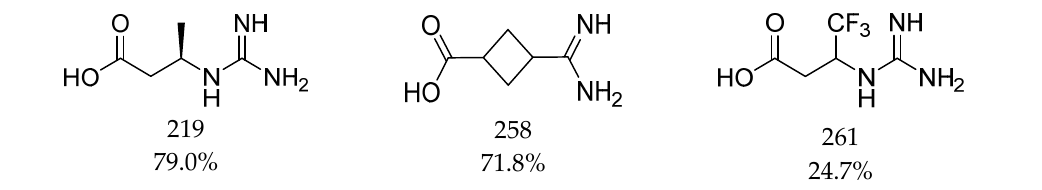
Figure 7. Creatine analogues tested against CT-1. Biological activity of compounds is expressed as inhibition percentage of creatine-d 3 uptake [71].